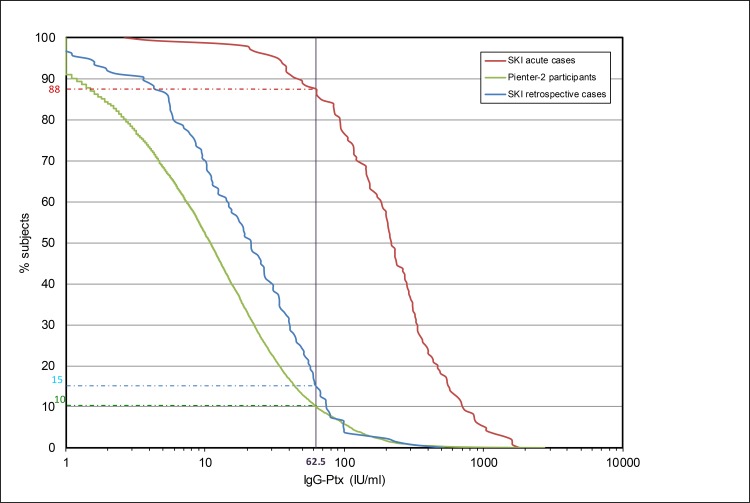
Reverse cumulative distribution curves of IgG-Ptx levels (IU/ml) measured in SKI and Pienter-2 cohorts.Shown are SKI acute cases, (dotted red line), SKI retrospective cases (blue line) and the population sample PIENTER-2 (green line). The vertical line indicates the pre-defined cut-off level of 62.5 IU/ml. The horizontal coloured lines indicate the percentages of the respective cohorts above the cut-off.